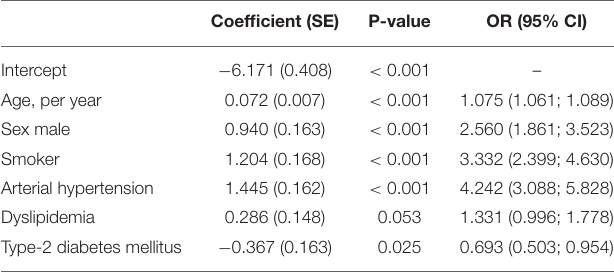
TABLE 3 | Multivariate logistic regression for Coronary Heart Disease